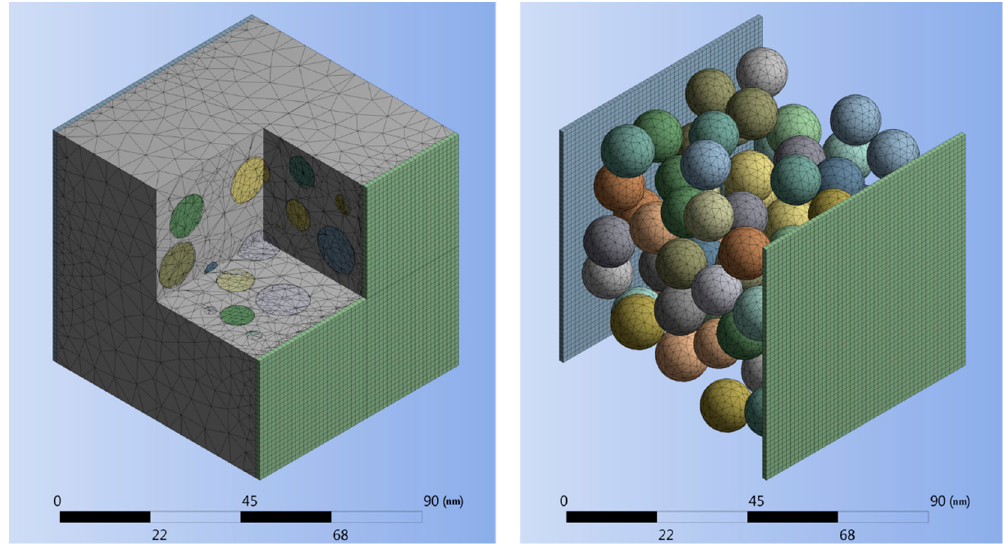
Figure 5. A cut-away view of the finite element mesh for RVE and electrical charge plates ( left ) and an isolated view of electrical charge plates and particles ( right ) for the 0.3 filler volume fraction.